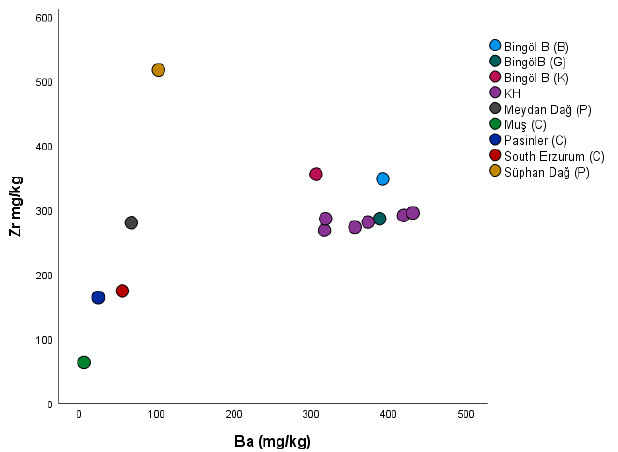
Figure 10. Ba vs. Zr scatterplot showing Kendale Hecala obsidian artefacts (KH-O-01, 02, 03, 04, 05 and 15) and obsidian sources of Eastern Anatolia: Bingöl B (G) [38].; Bingöl B (B) [39]; Bingöl B (K) [40], Süphan Da˘g (P) [40], Süphan Da ğ (P) [41].